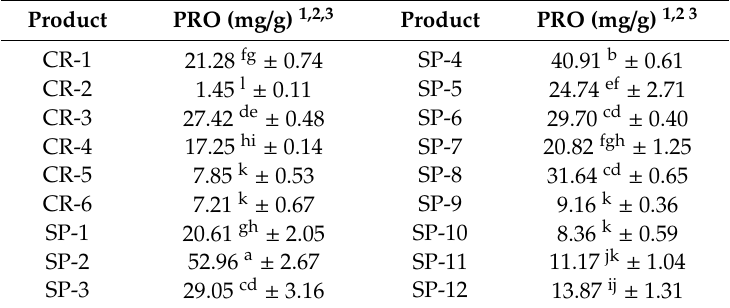
Table 4. Total flavan-3-ols (PRO) for extracts of U. tomentosa commercial